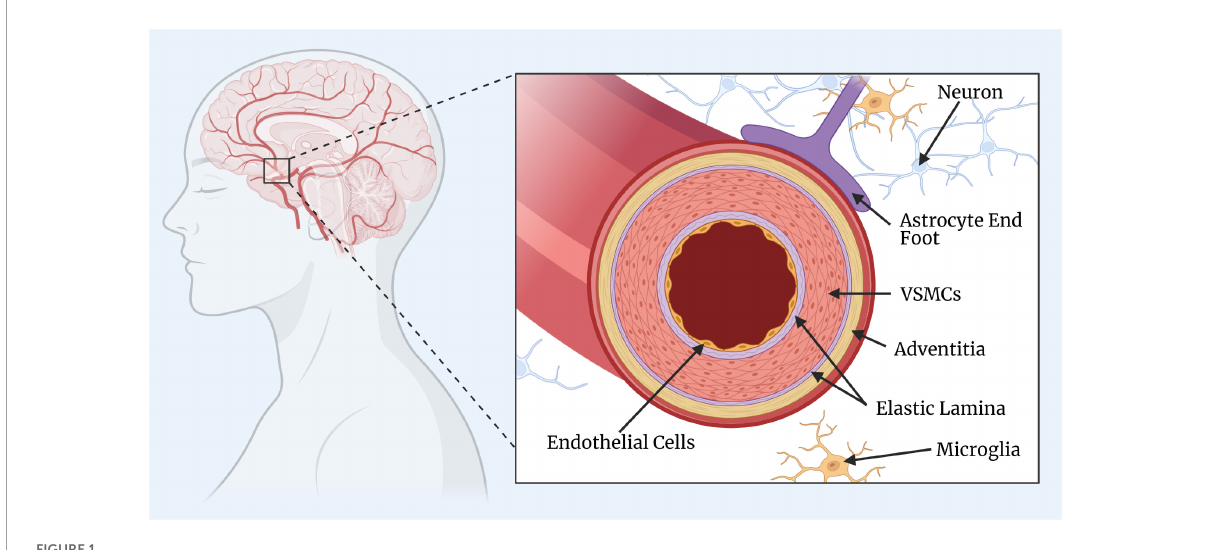
FIGURE1 Simplified diagram of a cerebral artery. The key components of the cerebral artery include the endothelial cells, elastic lamina (one internal and one external), vascular smooth muscle cells (VSMCs), and the adventitia layer. The surrounding and supporting cells include the astrocytes, microglia, and neurons. This figure was created by GH rendering using